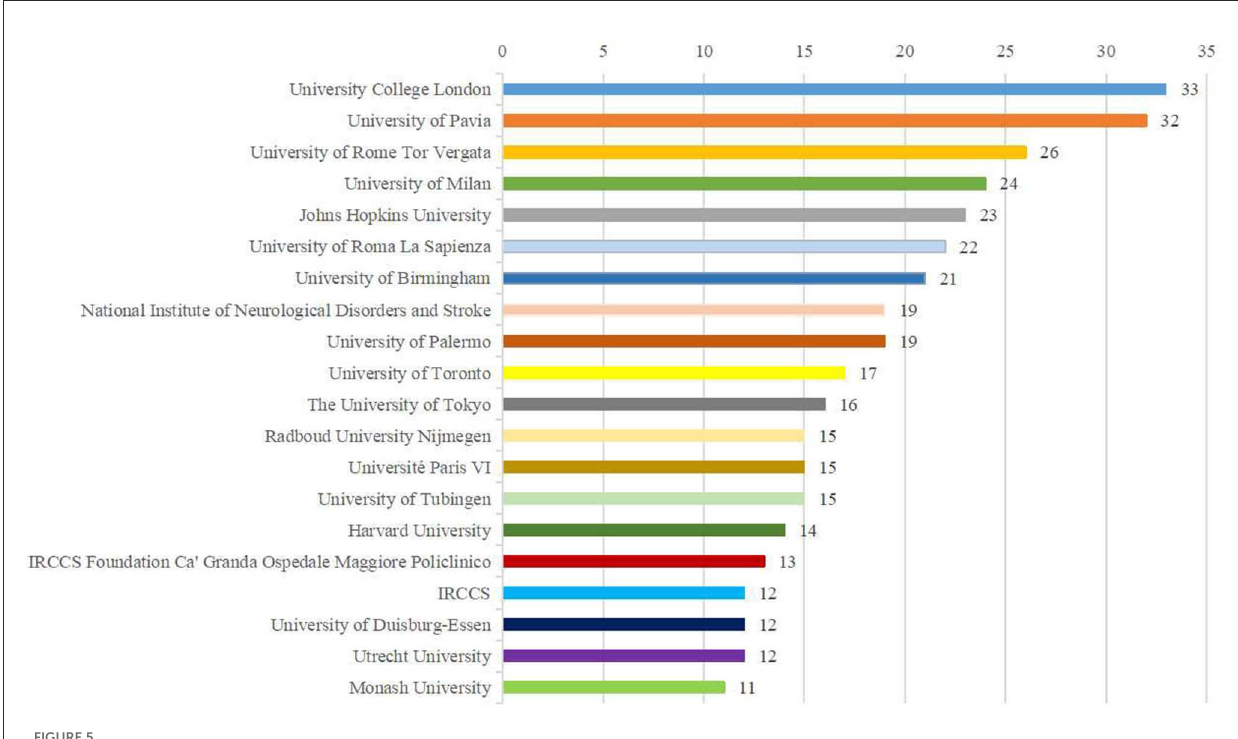
FIGURE5 The top 20 most productive institutions in the NICS